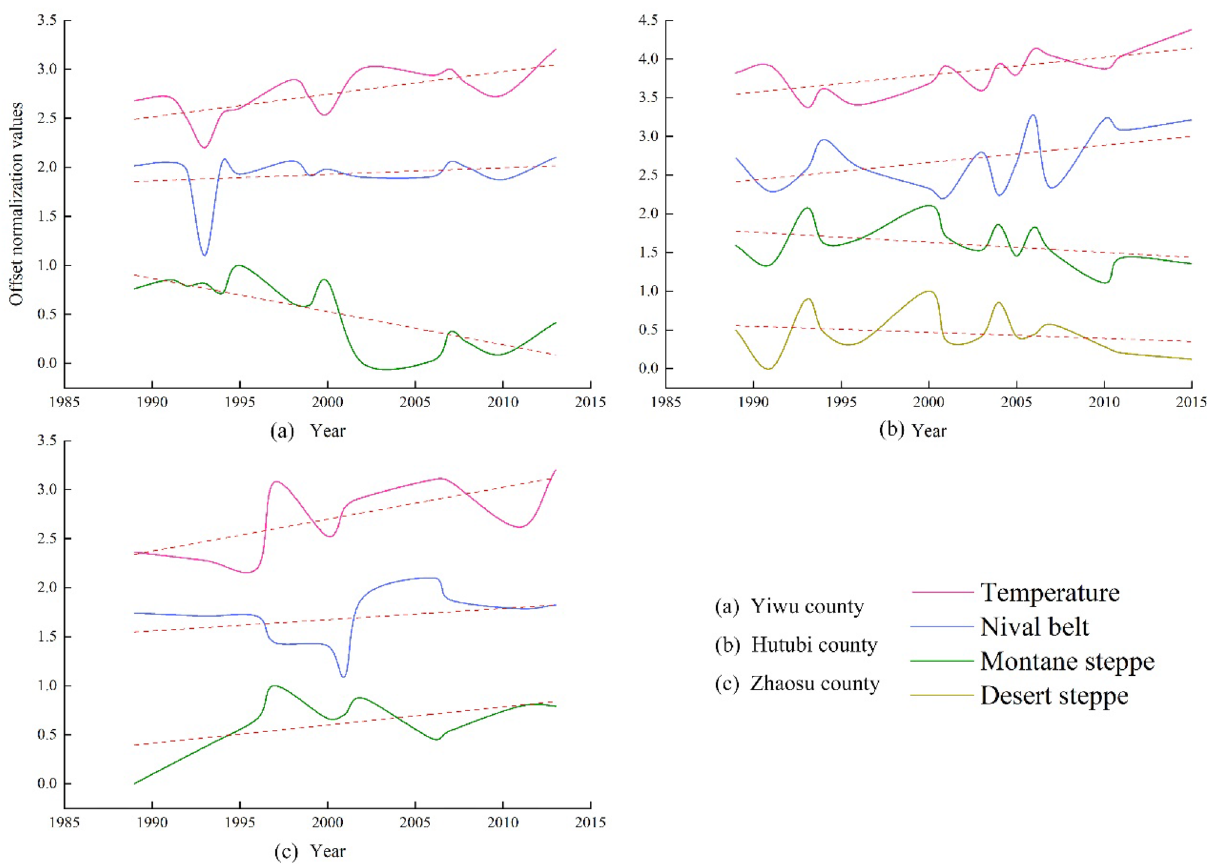
Figure 5. Temporal variation of temperature. [( a ) Yiwu county; ( b ) Hutu bi county; and ( c ) Zhaosu